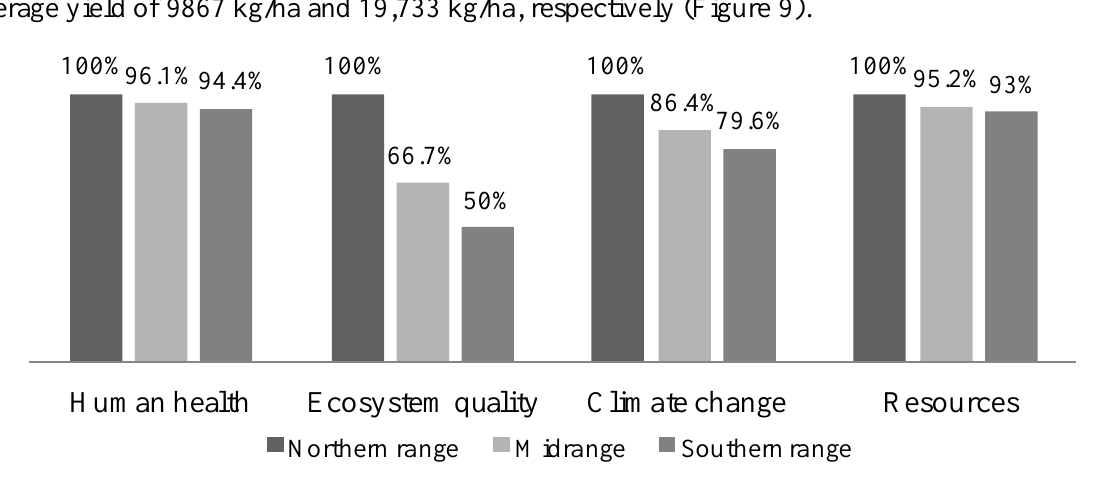
Figure 9. Damage assessment of producing syngas with various yields of